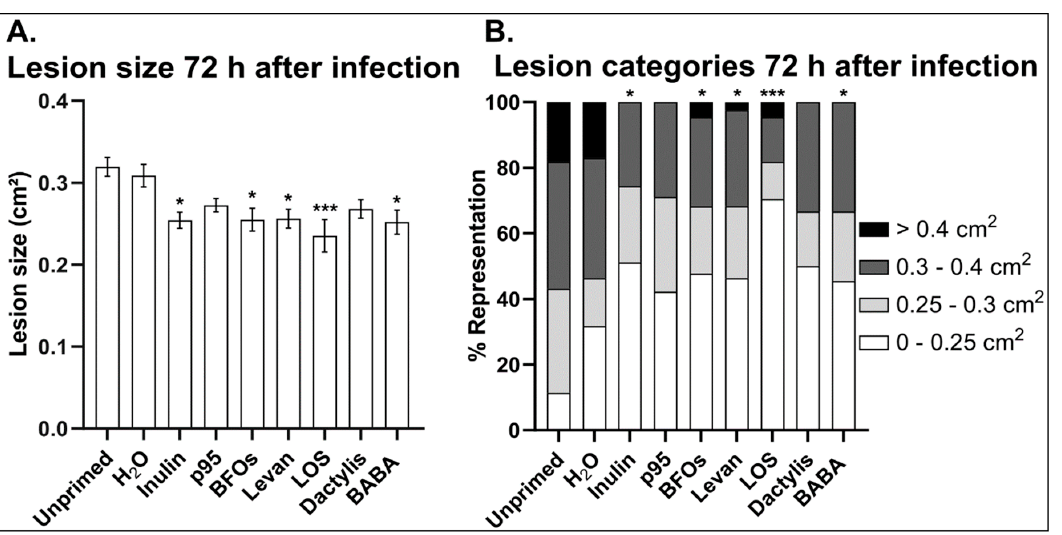
Figure 1. ( A ) Average lesion size of fructan-treated (5 g/L) plants compared to untreated and H 2 O controls. β -Aminobutyric acid (BABA) was used as positive control at 1 mM. Bars represent the mean ± SE of at least 40 biological replicates. ( B ) Disease severity of fructan-treated plants grouped into four different classes based on the percentage representation of their lesion sizes. Each treatment contained at least 40 biological replicates and was repeated three times with consistent results. Asterisks indicate statistical significance of the mean and SE against H 2 O treatment using one-way ANOVA followed by Dunnett’s multiple comparison test (* p < 0.05, *** p < 0.001).